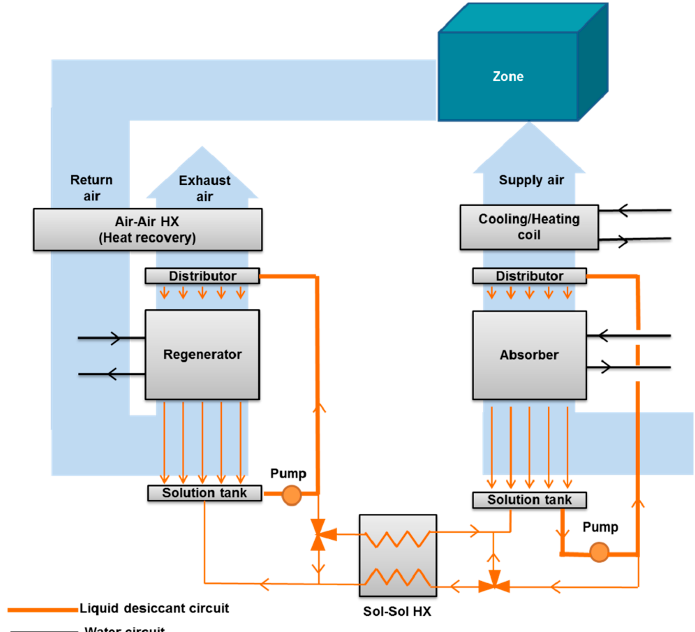
Figure 2. Schematic with the elements modeled for the dynamic simulations (adapted from